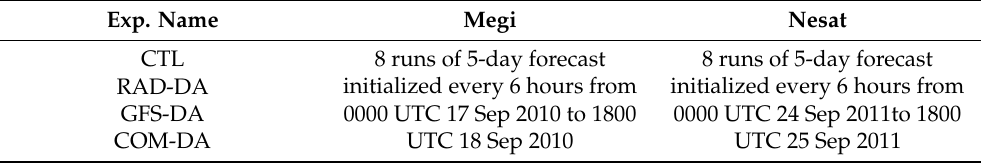
Table 3. Experiments included for further assessments in the study.